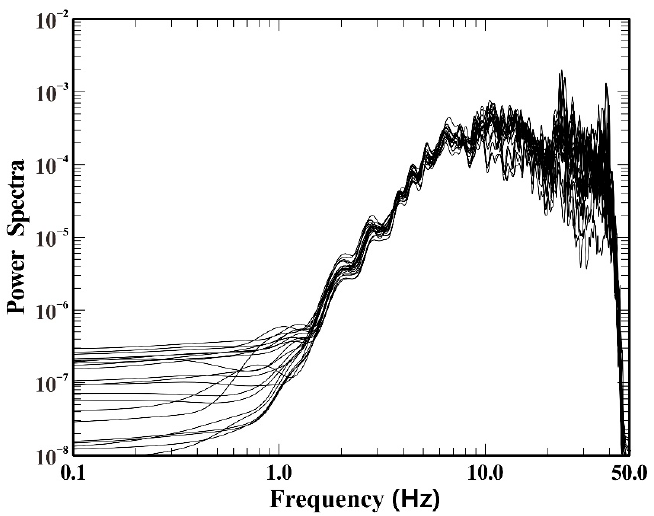
Figure 9. Power spectra of microtremor signals recorded by the corresponding stations of observa- tion system 1. system